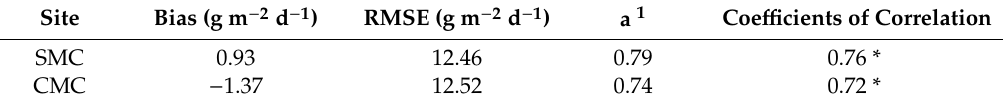
Figure 5. Comparison between observed and estimated CO 2 flux using 1 on 1 plot at ( a ) SMC and ( b ) CMC site. Table 4. Statistical comparison between estimated and in situ measurements of CO 2 flux.